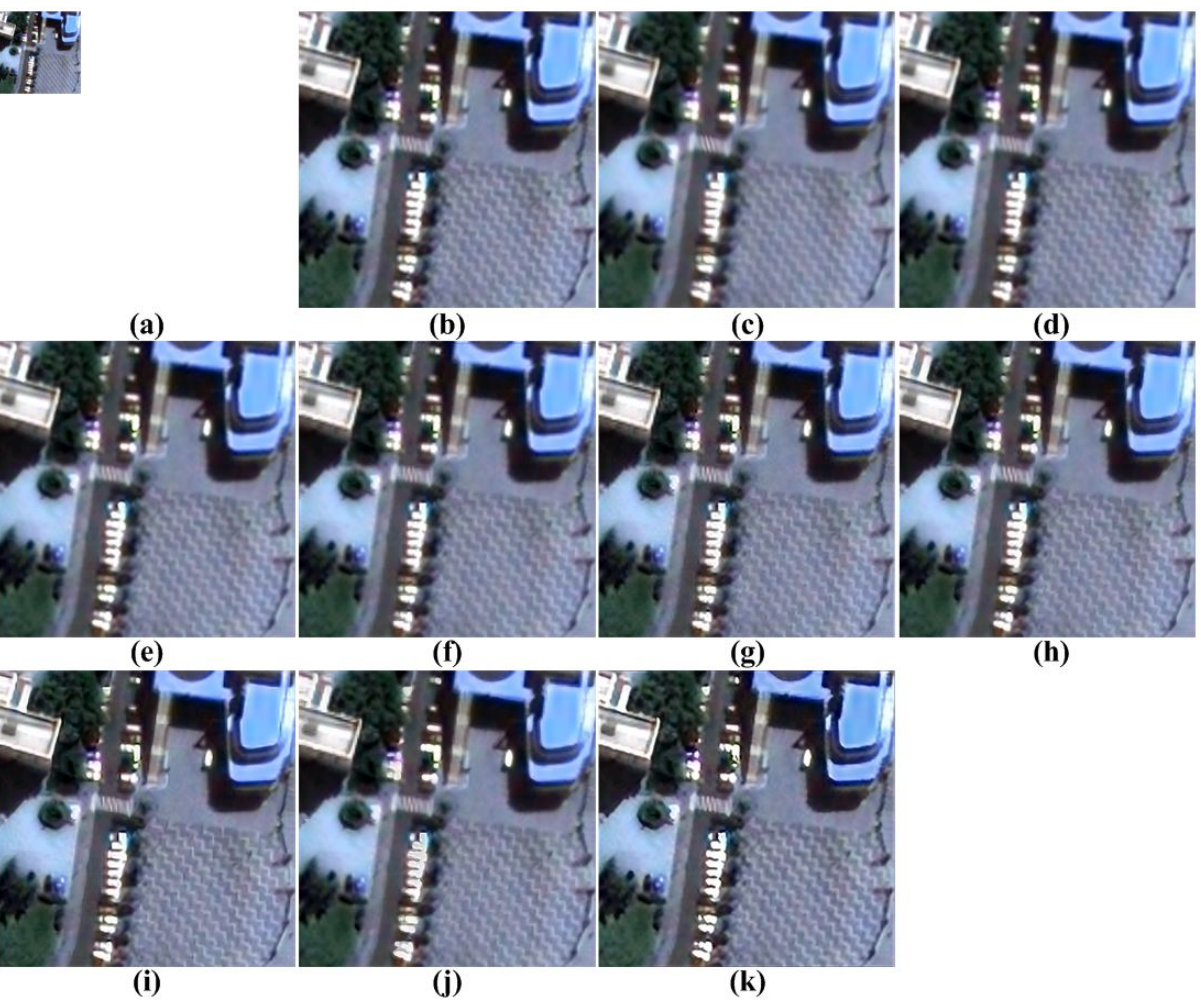
Figure 14. Results of resolution enhancement by enlarging a real UAV image: ( a ) original HR image in Figure 11c; result of: ( b ) cubic-spline interpolation [3]; ( c ) interpolation-based SR [4]; ( d ) interpolation-based SR [5]; ( e ) interpolation-based SR [6]; ( f ) example-based SR [7]; ( g ) patch-based SR [9]; ( h ) patch-based SR [10]; ( i ) patch-based SR [11]; ( j ) patch-based SR [12] and ( k ) the proposed